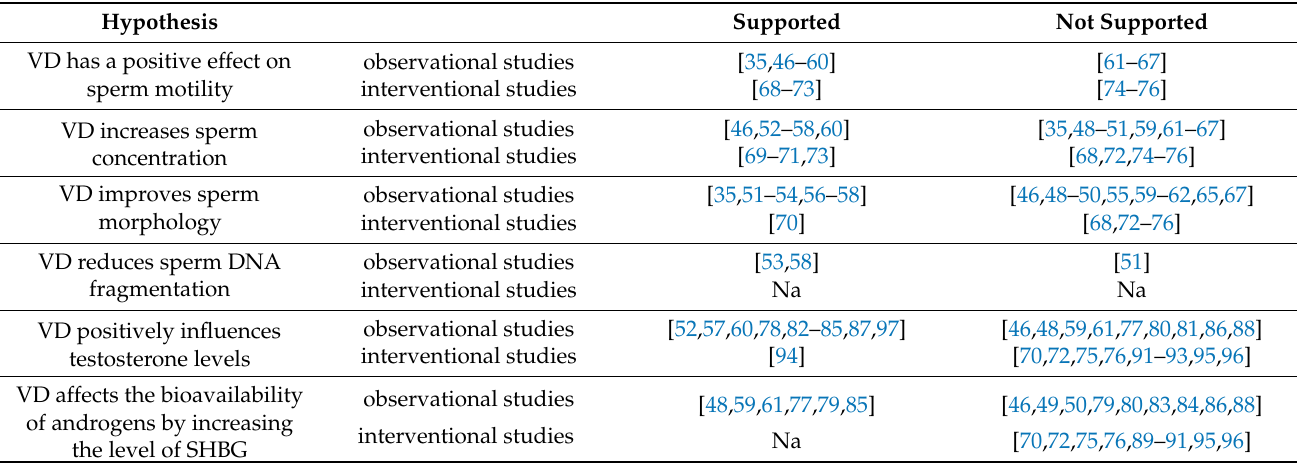
Table 5. Summary table of major